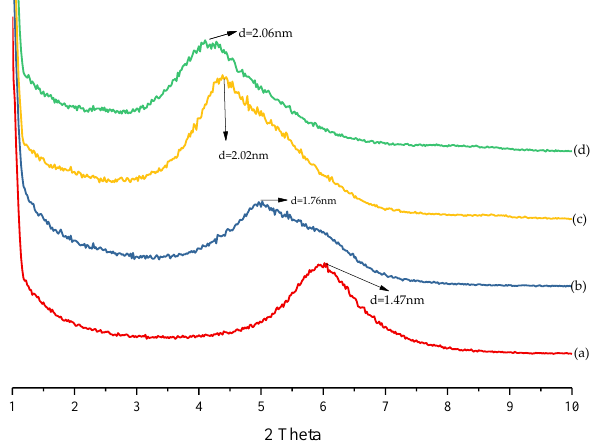
Figure 1. X-ray diffraction (XRD) patterns of (a) MMT-Na + ; (b) 1231-MMT; (c) 1631-MMT; and (d) 1831-MMT.